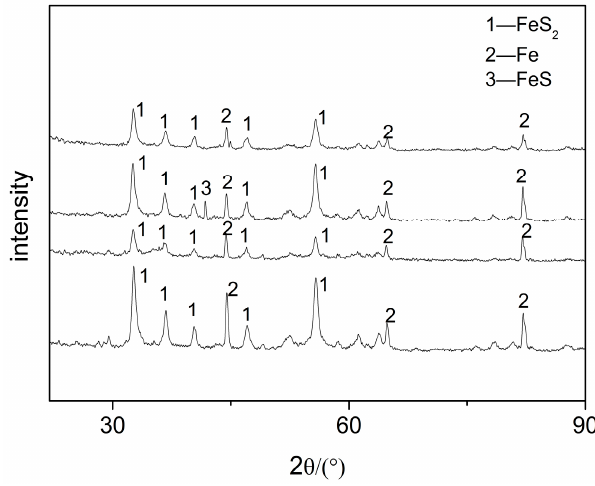
Figure 8. XRD images of the samples.